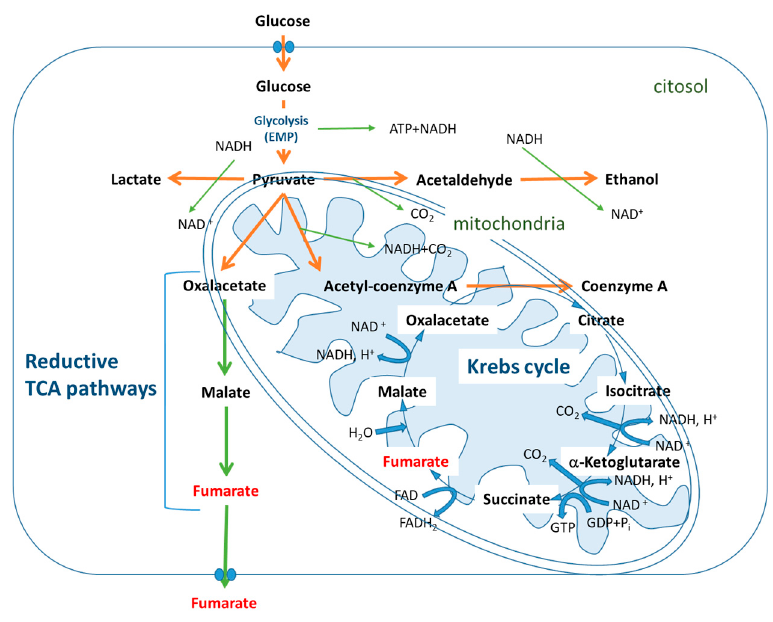
Figure 3. Pathways from glucose to fumaric acid (adapted from [31]).